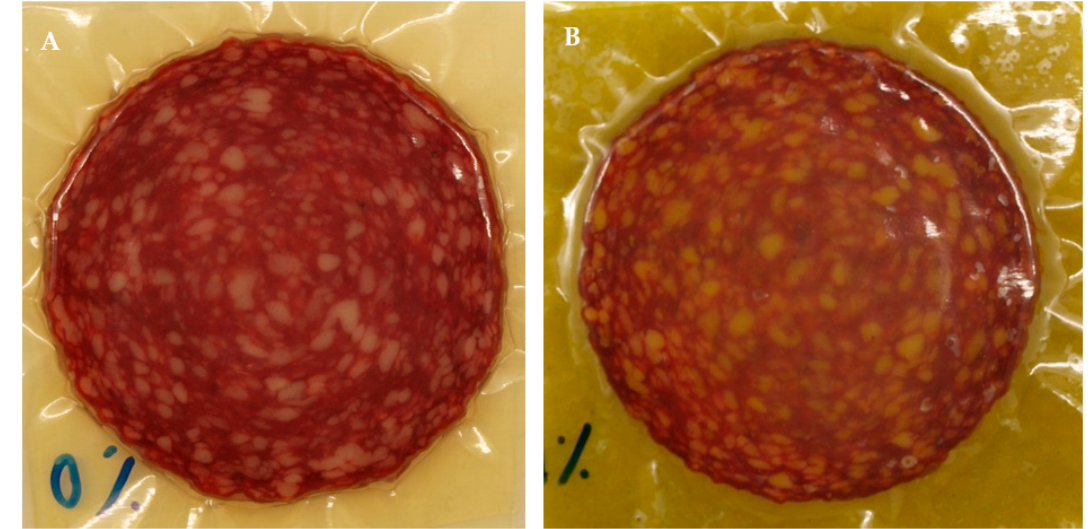
Figure 1. Salami slices packed with the control film ( A ) and the active film ( B ).